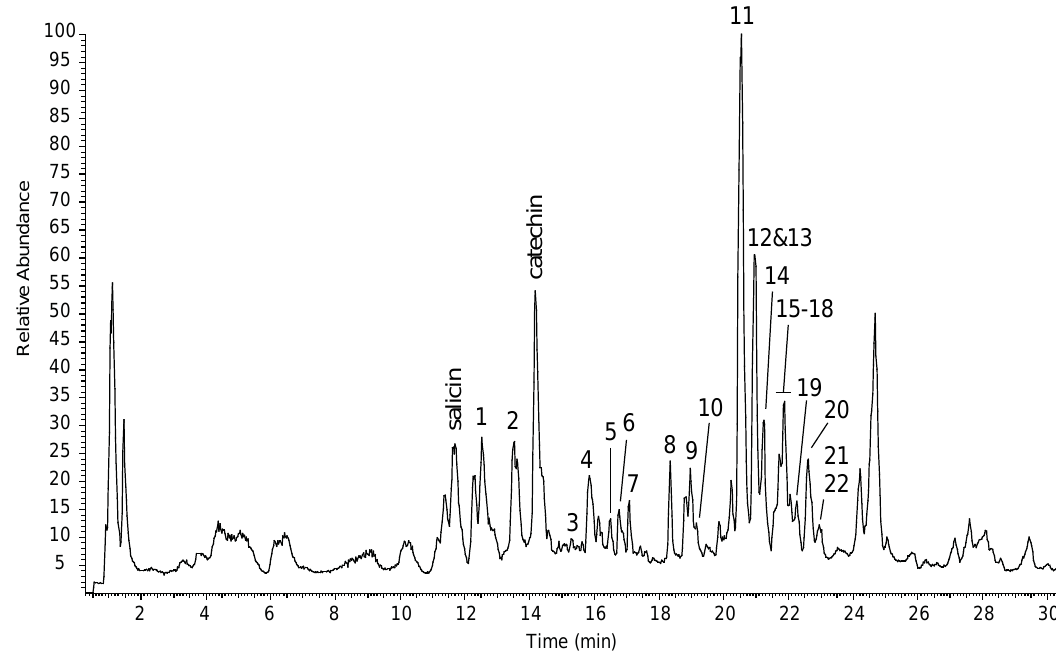
Figure 1. Total ion chromatogram (negative ion mode) extract generated from the Salix triandra × dasyclados hybrid (NWC1283) following extraction in water:ethanol (4:1).